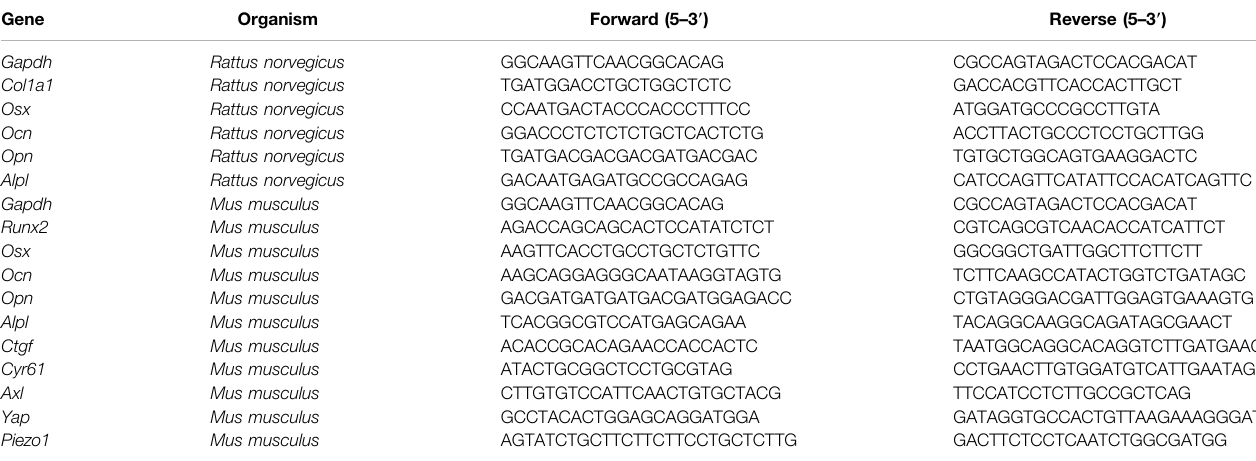
TABLE 1 | Primers used in the qRT-PCR